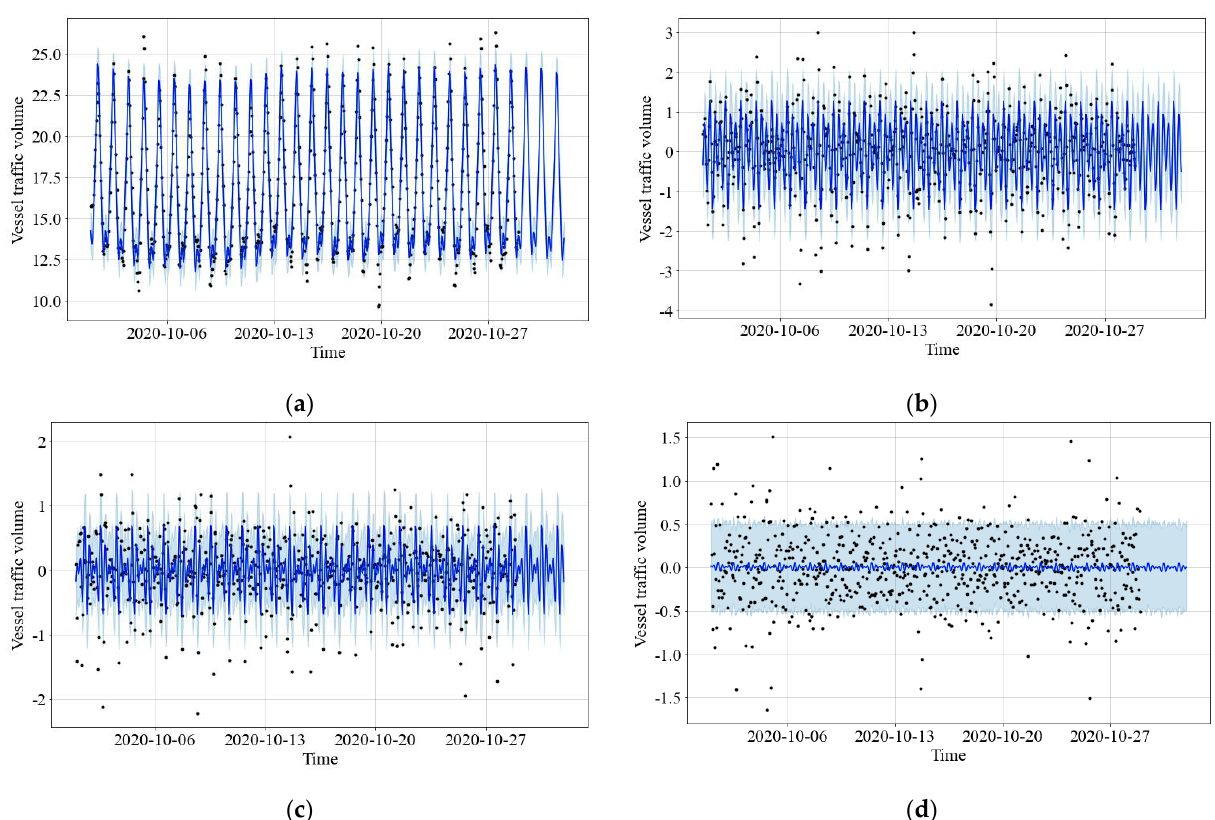
Figure 7. Prediction results of four components: ( a ) A 3 ; ( b ) D 3 ; ( c ) D 2 ; ( d ) D 1 . In Figure 7, the part of the shadow indicates the confidence interval of